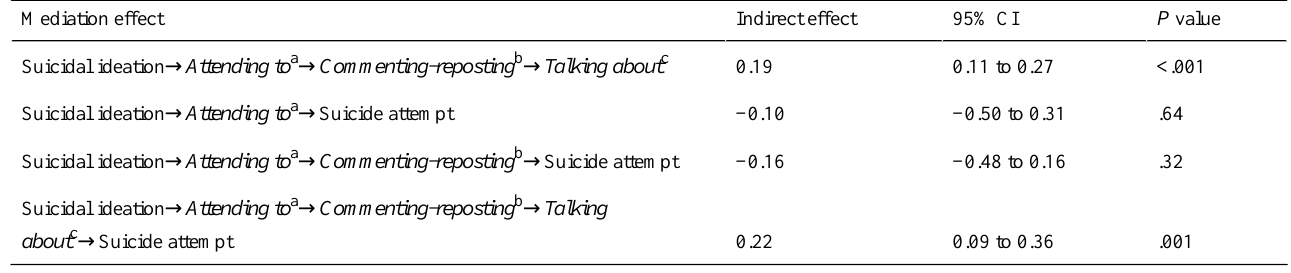
Table 5. Estimated mediation effects of attending to, commenting-reposting, and talking about behaviors in the association between suicidal ideation and suicide